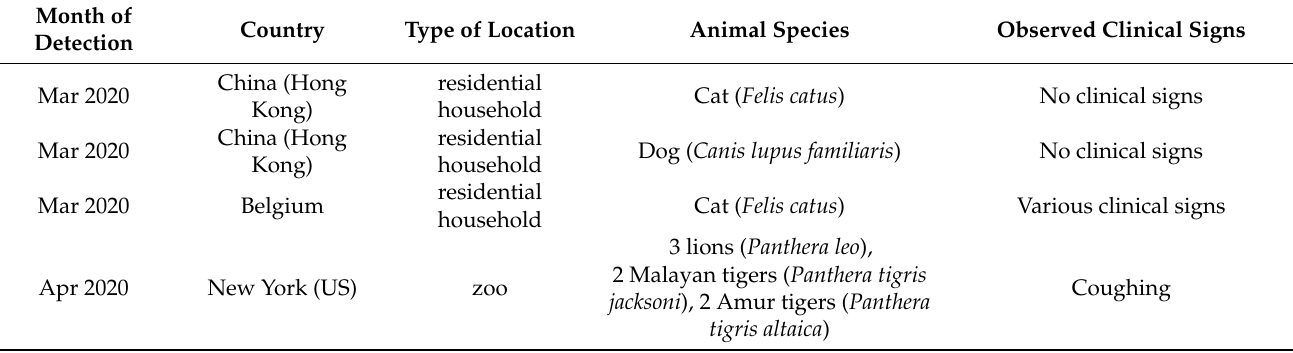
Table 2. Pets and wild Felidae found infected by SARS-CoV-2 (source ProMed mail messages: https://promedmail.org/ (accessed on 19 February